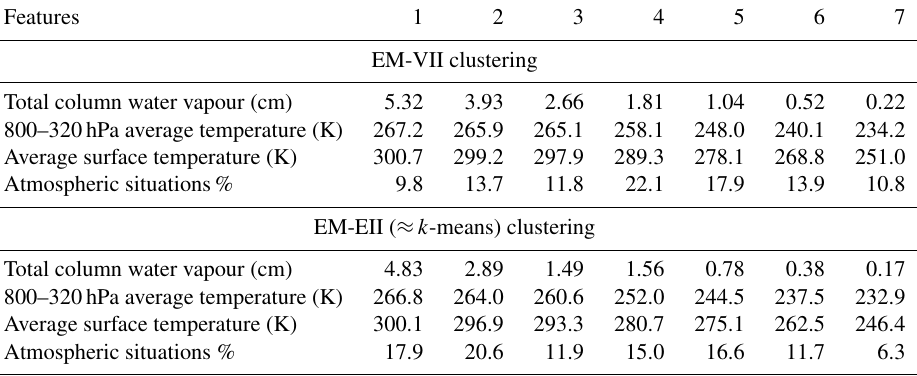
Figure 5. Average and associated standard deviation profiles for temperature (left) and dew point temperature (right) for each cluster obtained with EM-VII. The black line indicates the upper pressure level kept used for computing the cumulative distribution functions. Table 1. Main features of the air mass clusters. The percentages have been computed after discarding the high relief atmospheric situations, so that each sum of a given row equals